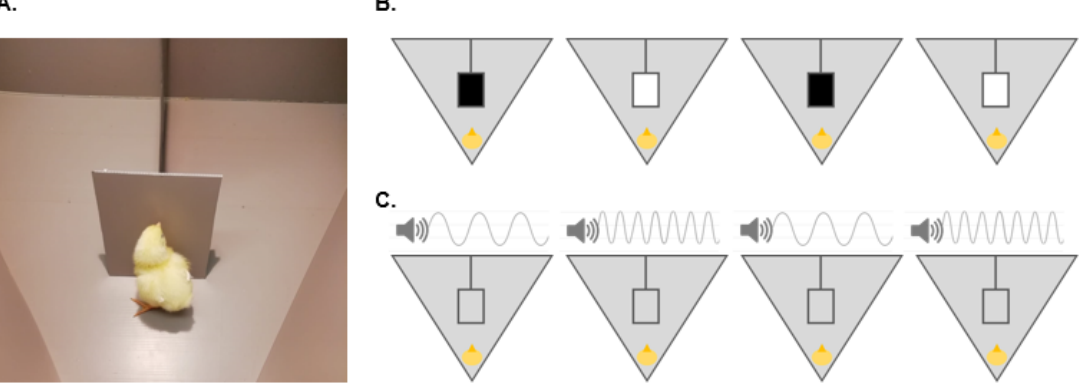
Figure 1. The three phases of the training procedure: ( A ). During the training procedure, a single gray panel is placed in front of the chick. The chick learns to circumnavigate the panel to obtain a small food reward. ( B ). Chicks are familiarized with the black and white panels in four consecutive rewarded trials, in which the two panels are alternated. Half of the chicks start with the black panel (as shown in the example); the other half start with the white panel. ( C ). Chicks are familiarized with high and low pitch sounds in four consecutive rewarded trials. In this case, the gray panel is used to avoid associating luminance and sound prior to test. Half of the chicks start with the low pitch (as shown in the example), while the other half start with the high ‐ pitch sound.